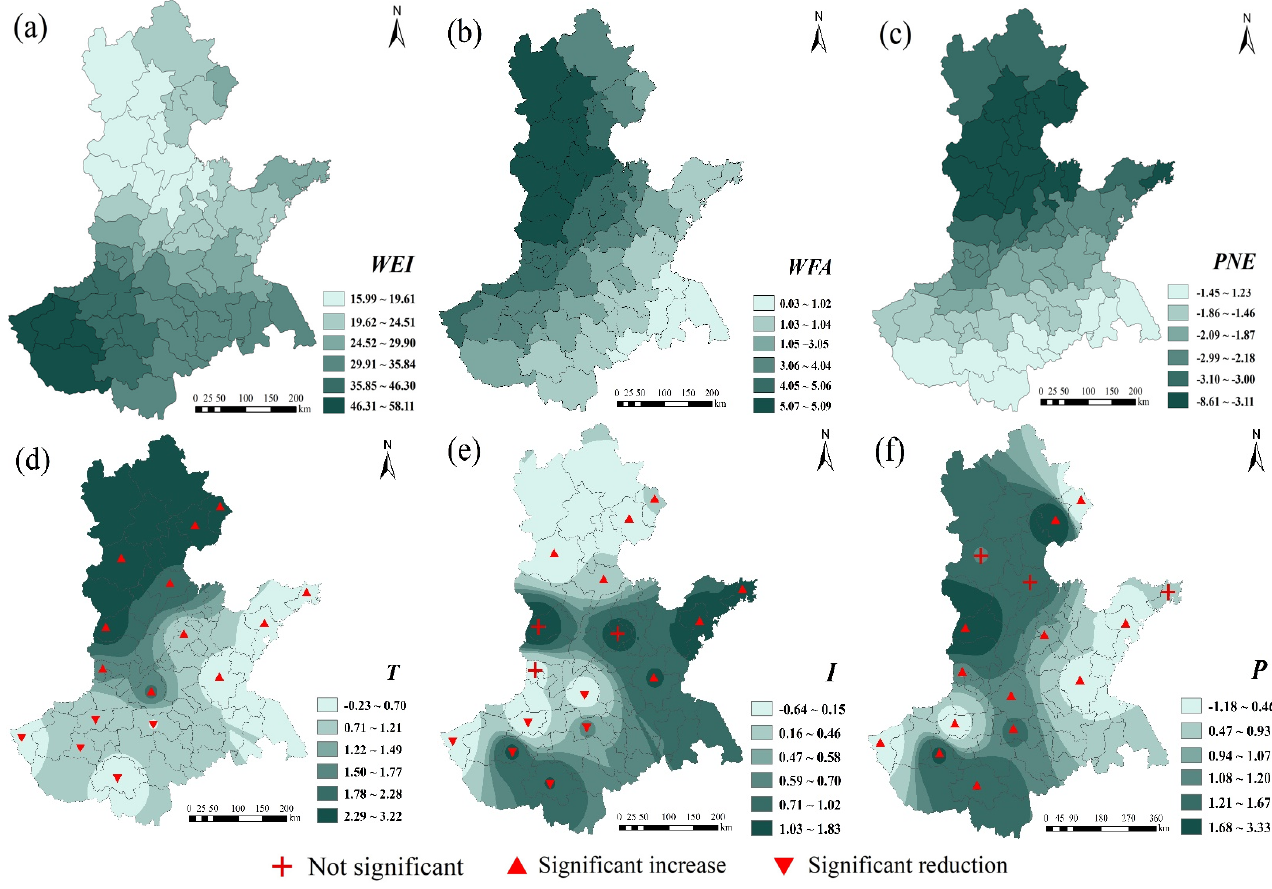
Figure 11. Spatial distribution of the regression coefficients for the SCA-GWR model in 2020: ( a ) WEI ; ( b ) WFA ; ( c ) PNE ; ( d ) T ; ( e ) I ; ( f ): P .